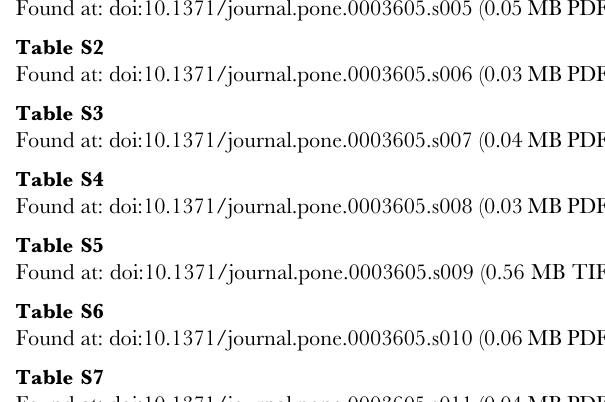
Figure S4 Differential responses of the T877A AR mutation. The differential effects of the T877A mutation on AR nuclear translocation, nuclear hyperspeckling, and transcriptional reporter gene activity in HeLa GFP-AR with selected compounds. Cells stably expressing either WT (unhatched) or T877A (hatched) forms of AR were transfected with pARR-2PB-dsRED2skl reporter vector and maintained in 5% SD-FBS media for 12 hr. Cells were treated with indicated compound either alone (grey bars) or with 10 nM R1881 (white bars) for 18 hr in 5%SD-FBS. Results normalized to negative (no treatment) and positive (R1881) controls. When possible, EC50 values were calculated using SigmaPlot 4-parameter curve fitting tool and presented 6 std. error. Data represents average of 4